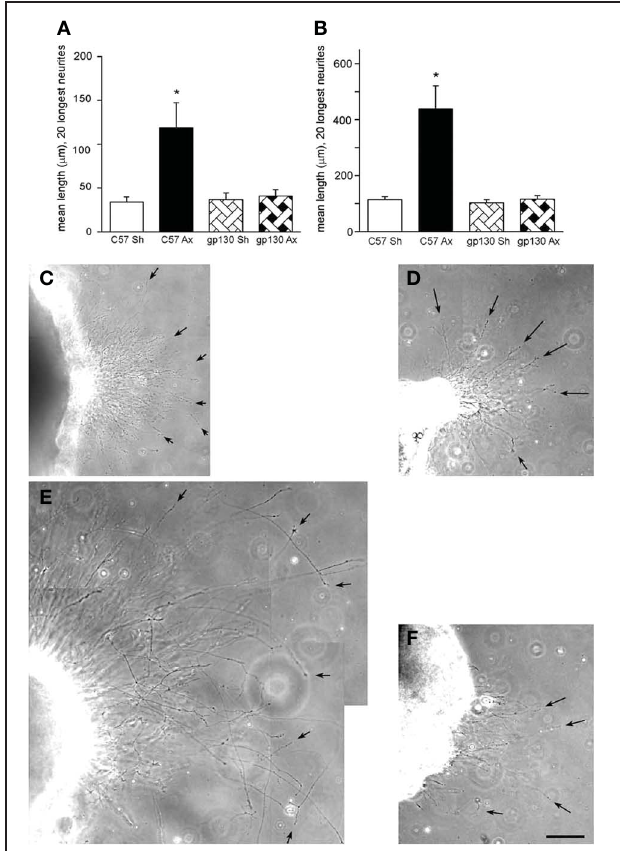
FIGURE 5 | (A, B) Neurite outgrowth was measured from explants of SCGs from wild type (C57) and gp130 DBHcre (gp130) mice following unilateral axotomy. Seven days following surgery, the ipsilateral (Ax) and contralateral (Sh) SCGs were placed in Matrigel and maintained in culture. Twenty-four (A) and forty-eight (B) hours later, the explants were photographed under phase contrast microscopy, and the lengths of the 20 longest neurites were determined. The data are presented as means ± S.E.M. for nine ganglia at 24h and for 6–9 ganglia at 48h. ∗ Represents a difference from the control value of the same genotype at p < 0 . 003 by a one-way ANOVA followed by Tukey’s post-test. (C–F) . Phase contrast micrographs of SCGs placed in explant culture for 48h. Ganglia from wild type (C, E) and gp130 DBHcre (D, F) mice placed in culture seven days after unilateral axotomy. (C) and (D) represent contralateral and (E) and (F) ipsilateral ganglia. Arrows point to individual neurites. The scale bar represents 100 μ m. The figure is from Hyatt Sachs et al.